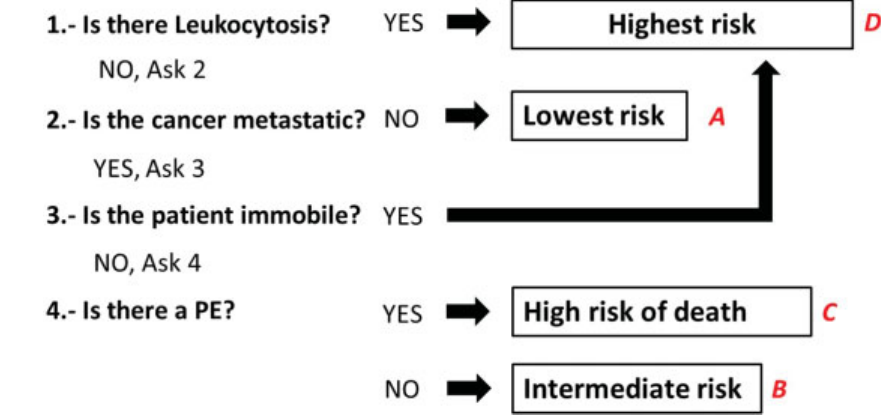
Fig. 2 Sequence of questions to de fi ne risk